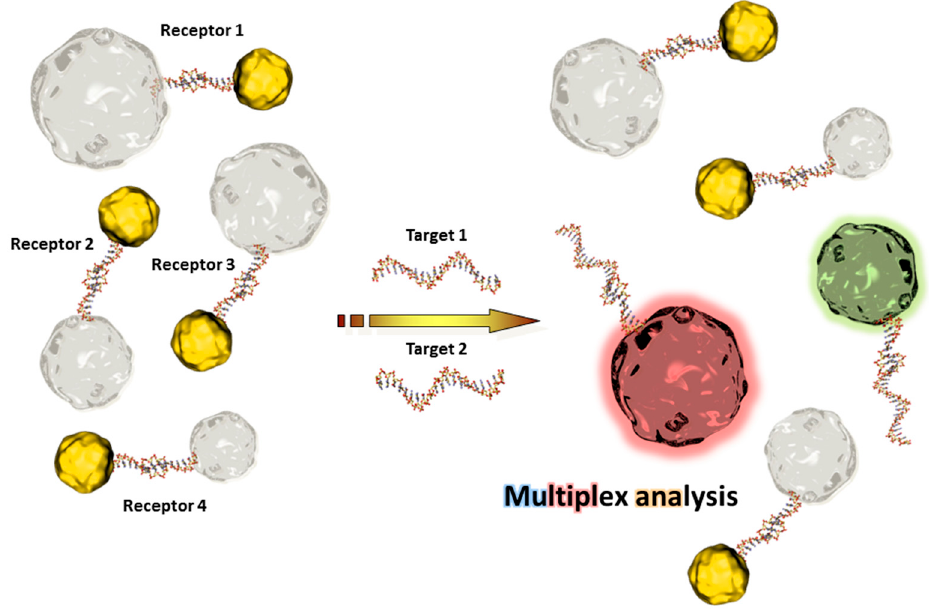
Figure 3. Scheme of a multiplex sensing principle using QDs and quenchers.